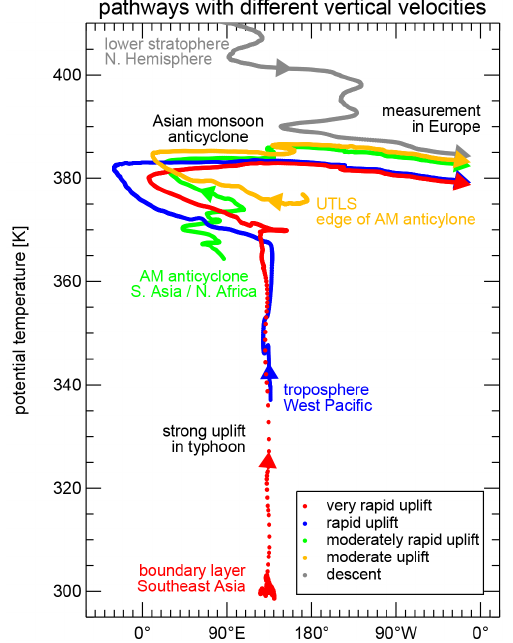
Figure 10. Selected trajectories representing characteristic path- ways with different vertical velocities (see Table 1) as a function of potential temperature and longitude for the time period between 17 August and 26 September 2012. The air mass positions are plotted every hour (coloured dots). Large distances between the single dots indicate very rapid uplift. The classification of the different vertical velocities is derived for the first 10 days of the trajectories (17–28 August 2012). For simplification, longitudes between 60 ◦ W and 20 ◦ E are shown twice. The coloured text gives information about the altitude origin and geographical origin of the different pathways. The figure illustrates different transport pathways of air masses with a different origin to the location of the measurement over northern Europe. The combination of very rapid uplift by a typhoon and east- ward eddy shedding from the Asian monsoon anticyclone yields fast transport ( ≈ 5weeks) from Southeast Asia boundary layer sources to northern Europe